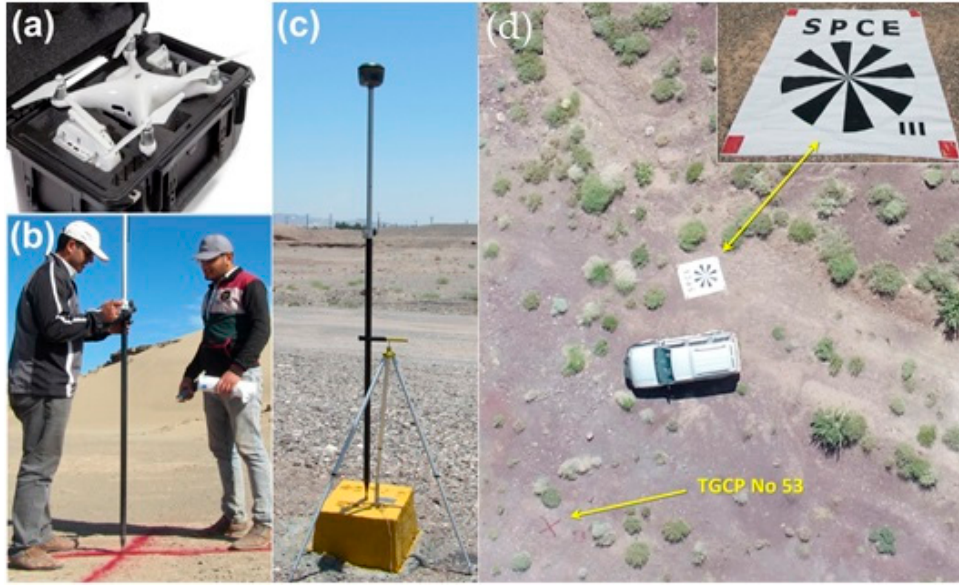
Figure 2. ( a ) DJI Phantom 4 Pro V2.0, ( b ) TGCP (marker), ( c ) SOUTH Galaxy G1+ receiver on a benchmark, and ( d ) Siemens star target.